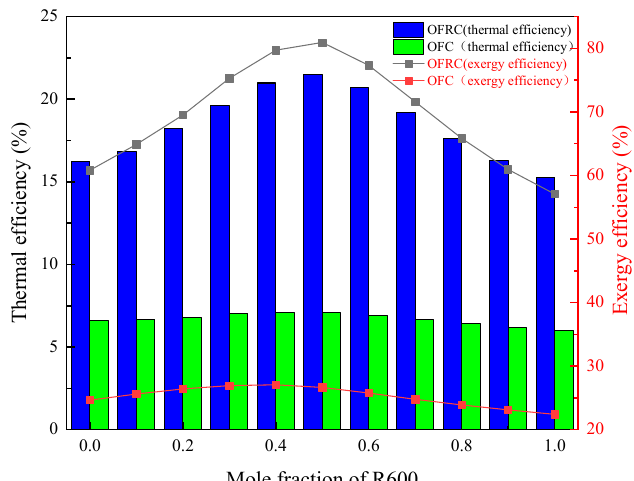
Figure 9. Variation of the thermal efficiency and exergy efficiency with the R600 mole fraction.